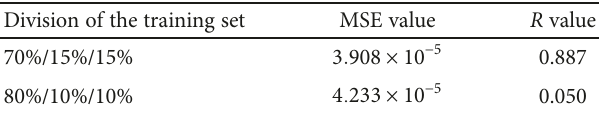
Table 10: Values of MSE and R depending on the division of the training set (for two neurons in the hidden layer and TRAINLM algorithm) in model ANN 3.